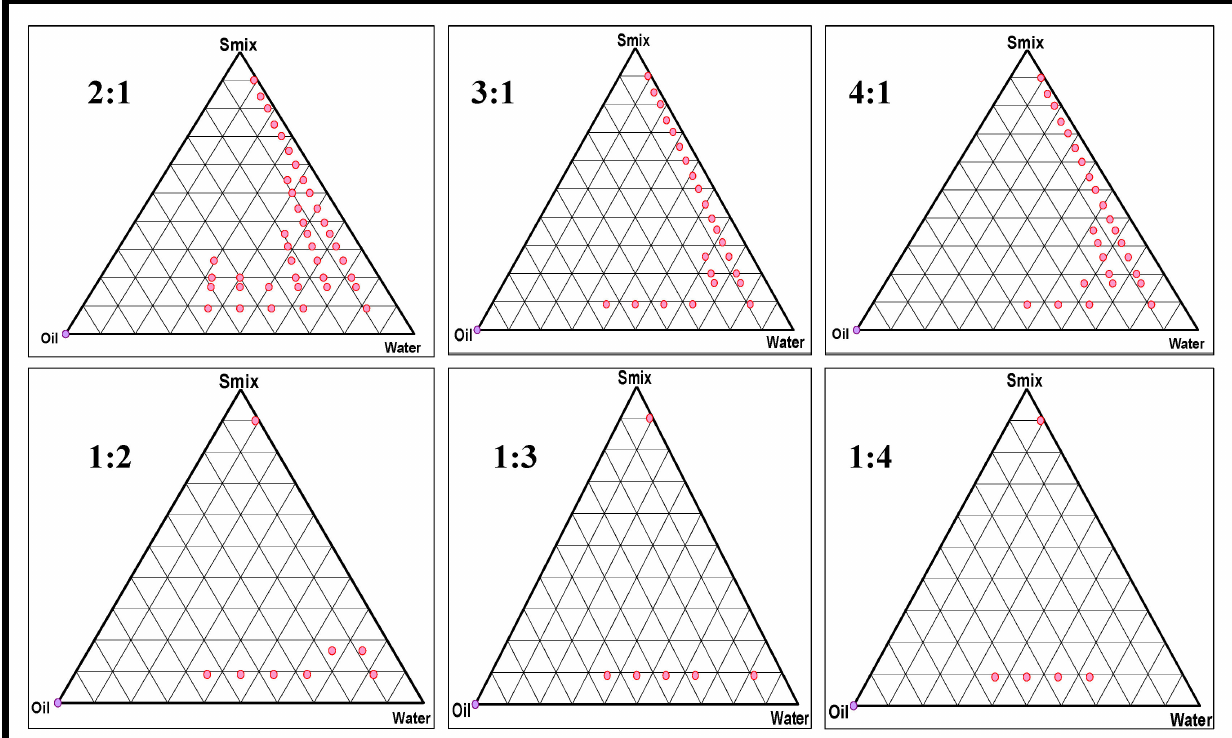
Figure 2. Pseudo-ternary phase diagrams for various Smix